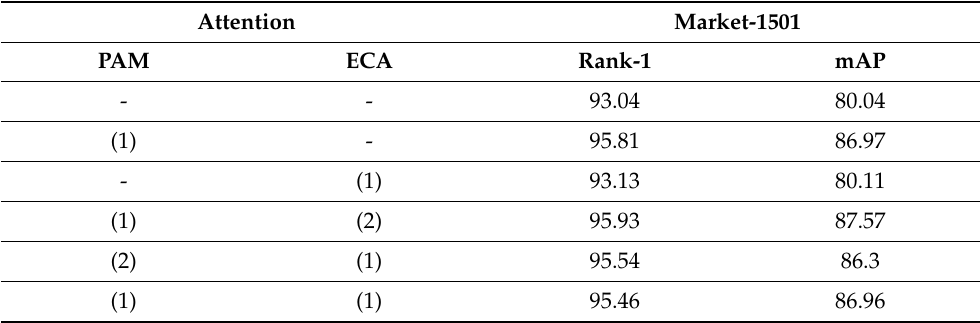
Table 6. Quantitative comparison of the attention module type on the Market-1501 dataset (where the number is the order of the attention